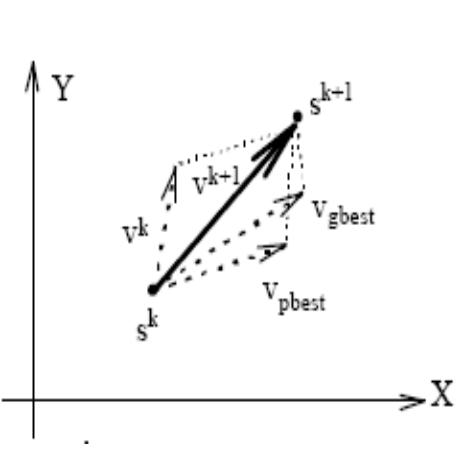
Fig. 2. Searching point in solution space